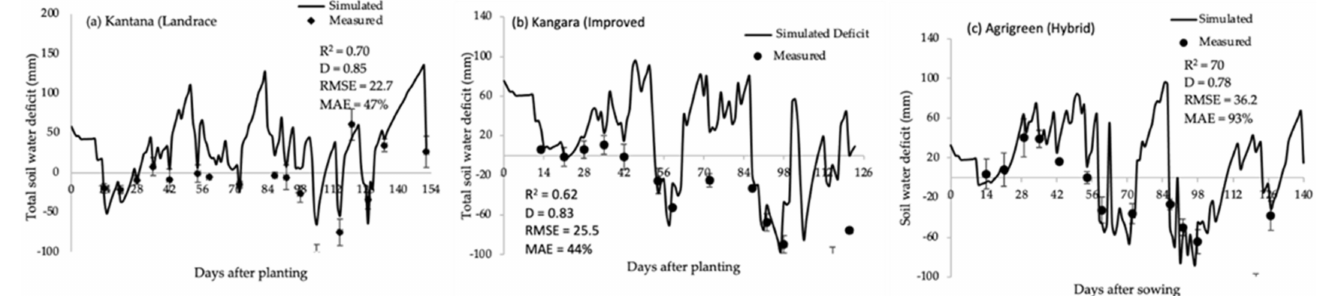
Figure 5. Simulated (solid lines) and measured values (points) of soil water deficits of three pearl millet varieties: ( a ) landrace, ( b ) improved and ( c ) hybrid the value shown on horizontal line is the average total water deficit.